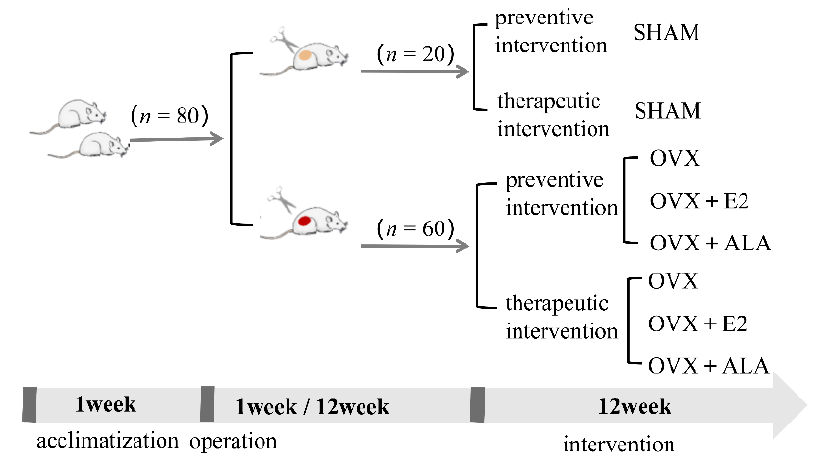
Figure 1. Rats grouping and intervention methods.